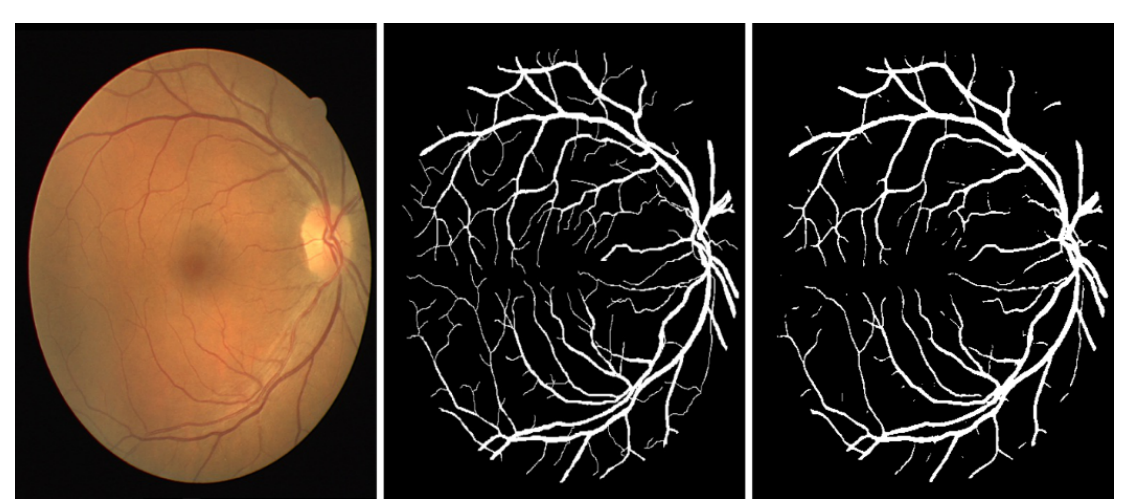
Figure 5: U-net fundus image and mask